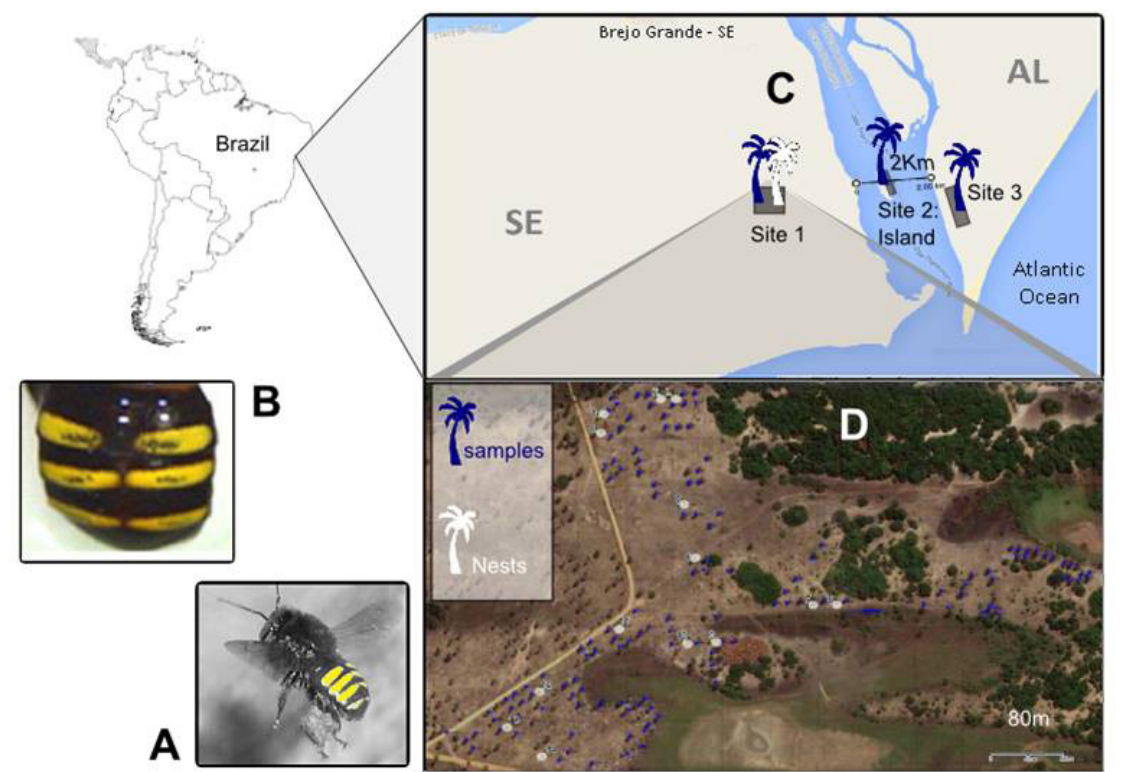
Fig 2 . Sampling area and nesting sites of M. quadrifasciata in coconut groves of the river São Francisco region. A- M. quadrifasciata ; B-detail of tergal bands of the collected workers; C- sampling sites: site 1 where 14 colonies of M. quadrifasciata were found, site 2: Criminosa island and site 3: left margin, state of Alagoas.